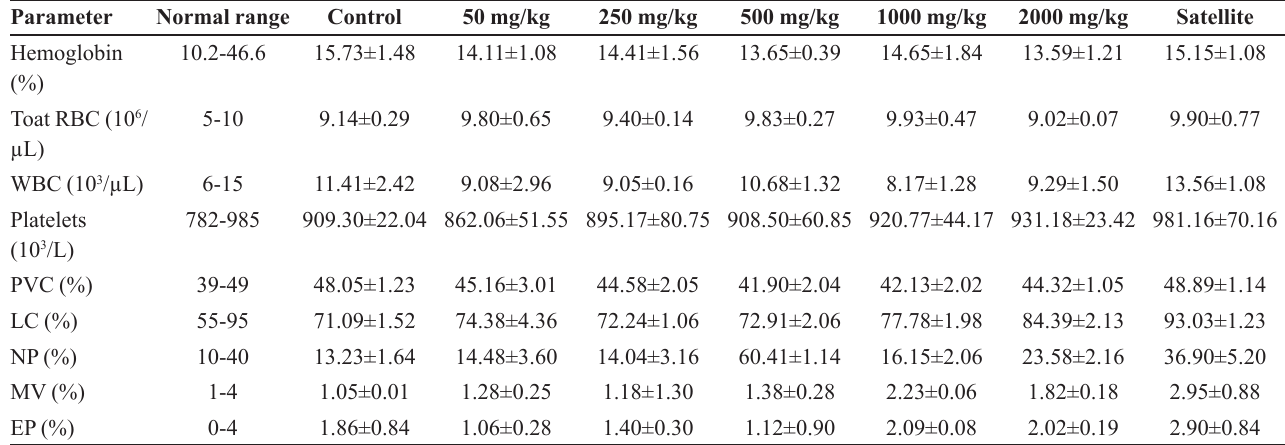
TABLE III - Hematological parameters of rat treated with the different dose level of AERI in sub-acute toxicity after 14th day Parameter